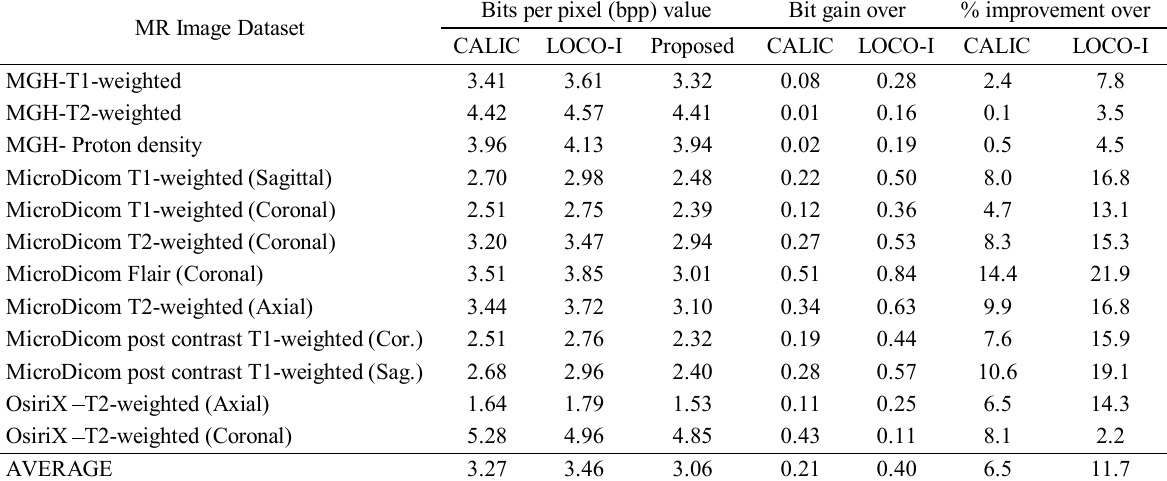
Table 6. Comparison of lossless compression performance of the proposed method with the CALIC and the LOCO-I. MR Image